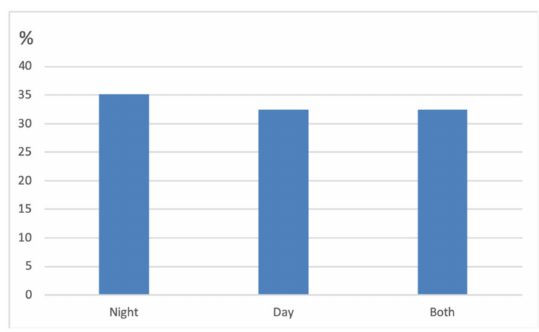
Figure 2. Bar chart illustrating the time of the day the cats most commonly vocalised.